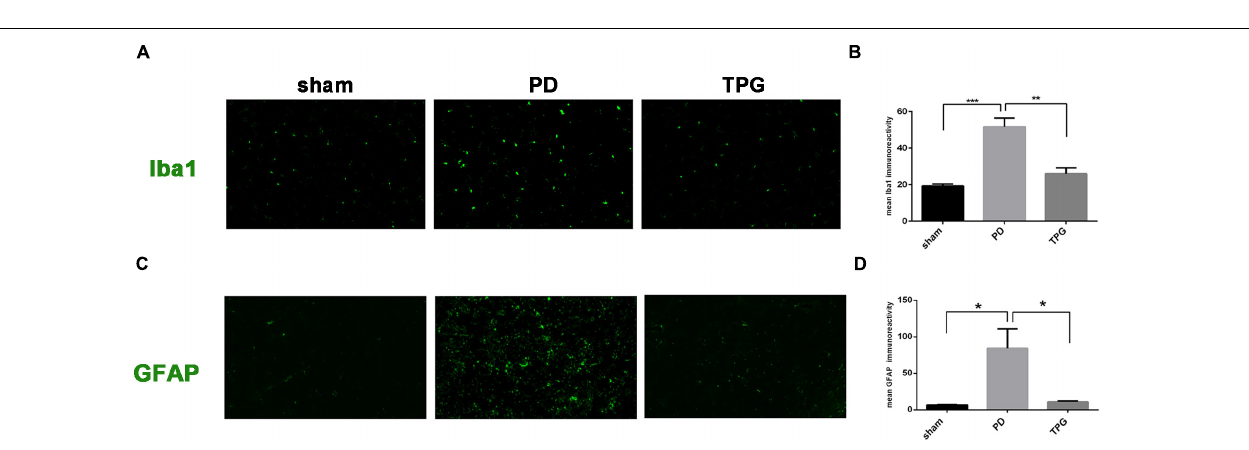
FIGURE 8 | TPG inhibited peripheral proinflammatory cytokine levels. ELISA was used to detect the level of (A) TNF- A , (B) IL-1, (C) IL-2, (D) IL-4, and (E) IL-6 protein in SD rats of each group. # p < 0.05, ## p < 0.01, ### p < 0.001 vs. PD group; ** p < 0.01 sham group.